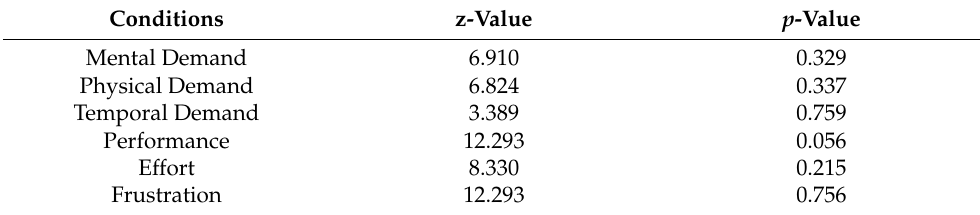
Table 3. Significant values for NASA-TLX score in ego vehicle